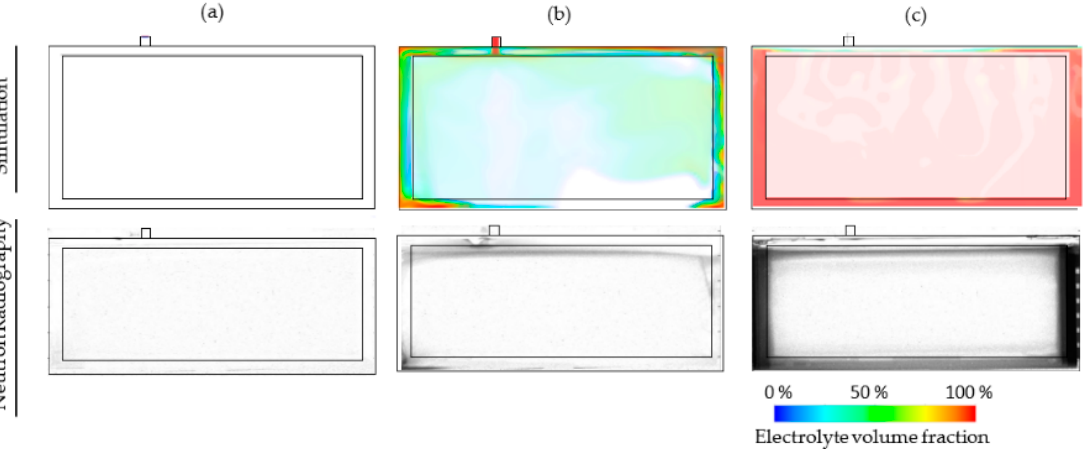
Figure 6. Comparison of the simulation results with images taken using neutron radiography for time steps ( a ) before dosing, ( b ) 0.25 s after dosing and ( c ) 15 s after dosing. The initial pressure (p init = 50 mbar), pressure difference ( Δ p = 250 mbar) and temperature (T = 25 °C) are set as process